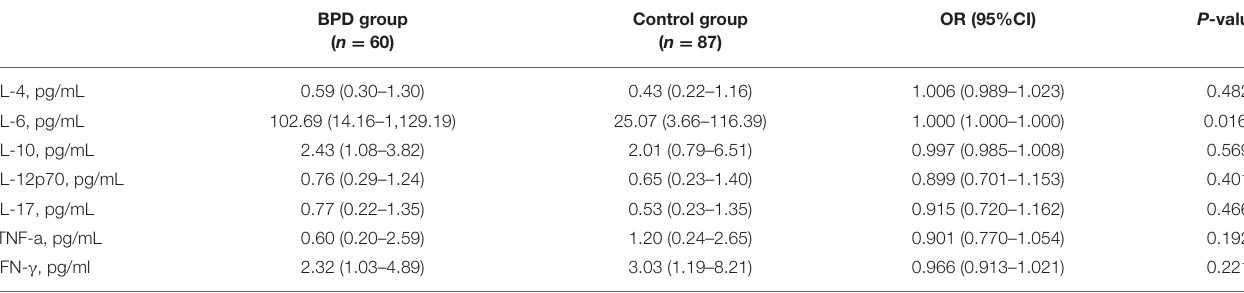
TABLE 4 | Univariate regression analysis of umbilical cord cytokine levels in infants with and without BPD.